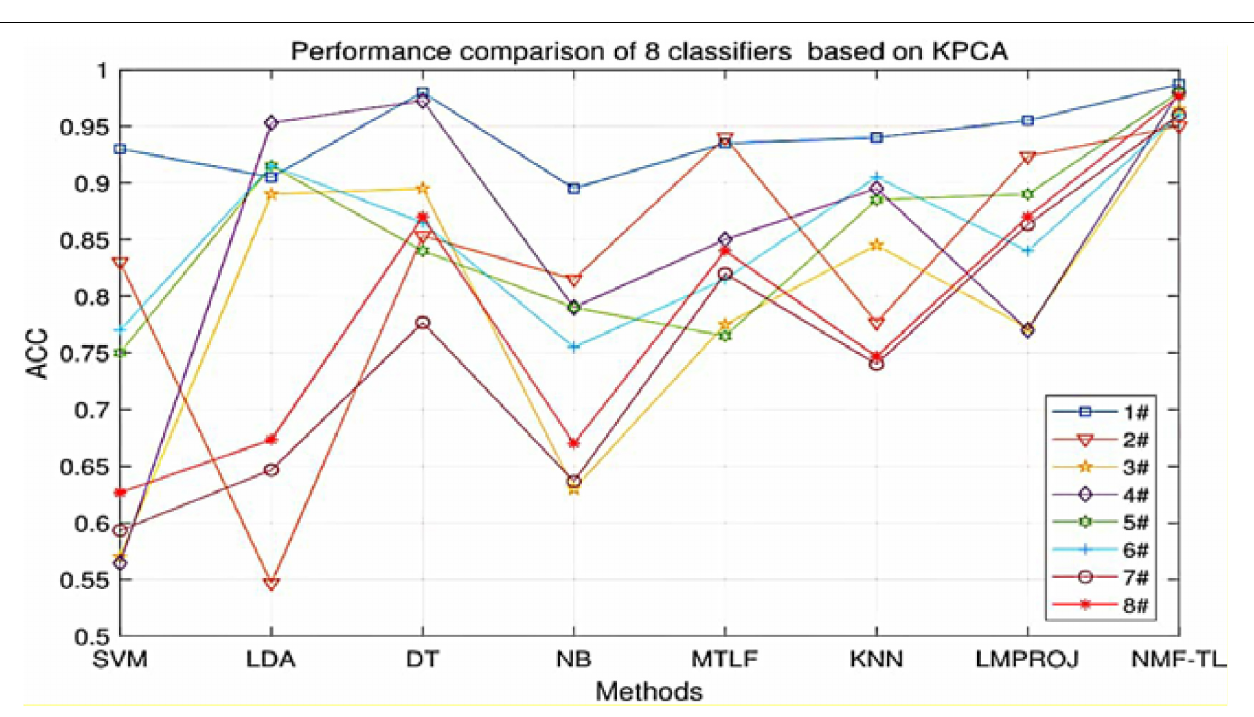
Frontiers in Neuroscience |